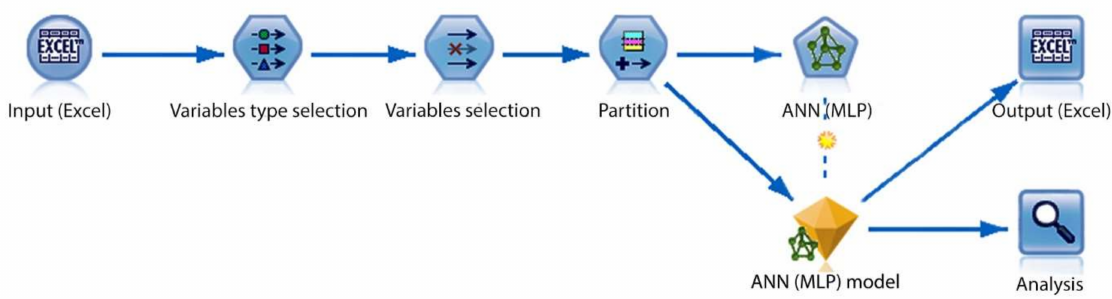
Figure 5. Developed data stream in IBM SPSS